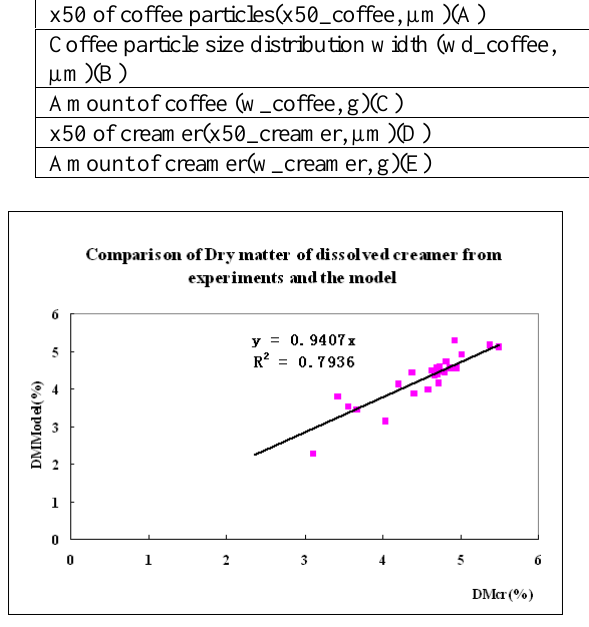
Fig. 8. Comparison of Dry matter calculated from the model ( DMModel ) and those from the experiments ( DMcr ).